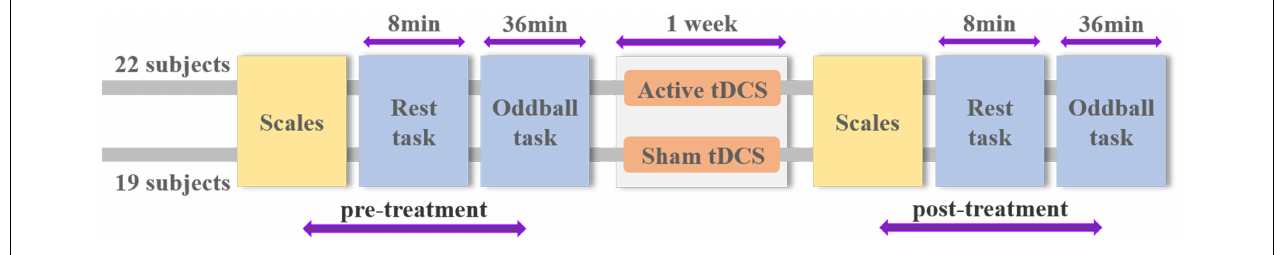
FIGURE 1 | Schematic overview of experimental design and